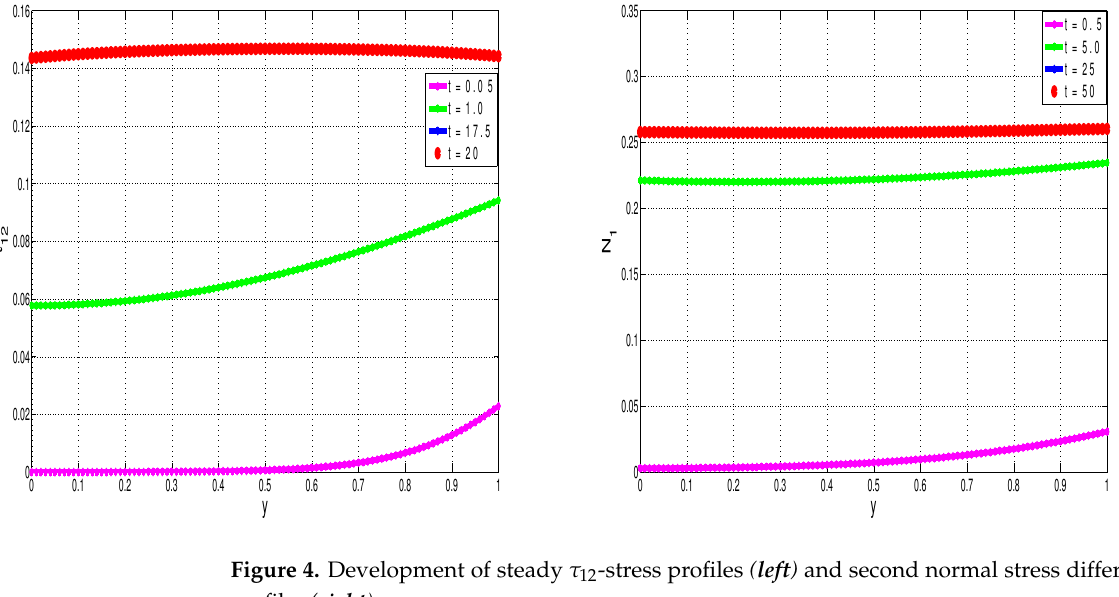
Figure 4. Development of steady τ 12 -stress profiles ( left ) and second normal stress difference ( N 1 ) profiles ( right ) .